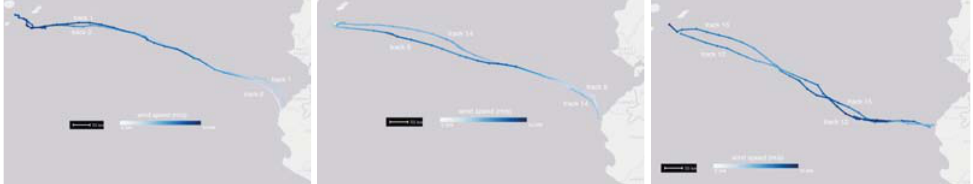
Figure 11: Flights of Albatross from the Galapagos to the coast. The left pair stays similar, the middle pair becomes less similar, and the right pair becomes more similar.